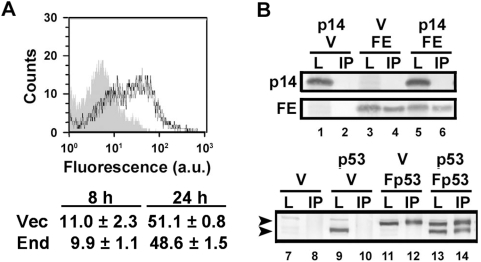
The endodomain functions as a fusion enhancer independent of direct interactions with the fusogen.(A) Top panel: Live cells co-transfected with p14G2A and the p14 endodomain (black lines) or empty vector (grey lines) were immunostained using anti-p14ecto antiserum and analysed by flow cytometry. Grey-filled histogram represents auto-fluorescence from mock-transfected cells. Bottom panel: Surface expression of p14G2A at 8 h and 24 h post-transfection in cells co-transfected with empty vector (Vec) or the p14 endodomain (End), as determined by flow cytometry and Overton subtraction relative to mock-transfected cells. Numbers indicate the mean fluorescence intensity increase above mock-transfected cells±S.D. from a representative experiment in triplicate. (B) Cells were co-transfected with the indicated expression plasmids (p14, authentic p14; V, empty vector; FE, FLAG-tagged endodomain; p53, authentic p53; Fp53, FLAG-tagged p53), and cell lysates were immunoprecipitated using anti-FLAG antibody. The immunoprecipitates (IP) and unfractionated cell lysates (L) were processed for Western blotting using anti-p14 (top panel) or anti-p53 (bottom panel) antibodies. The top arrow in the bottom panel indicates the migration of FLAG-tagged p53 and the bottom arrow untagged p53.